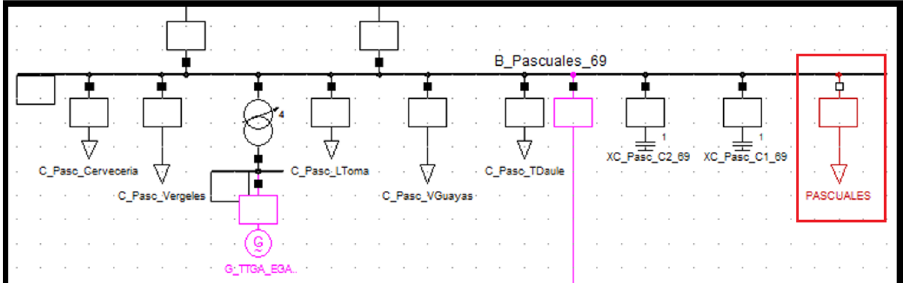
Figure 5. Pascuales static (general) load model representation.